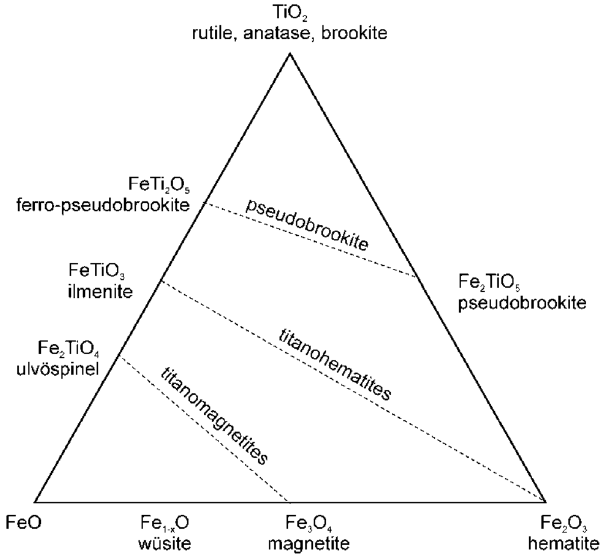
Figure 1. FeO-Fe 2 O 3 -TiO 2 ternary